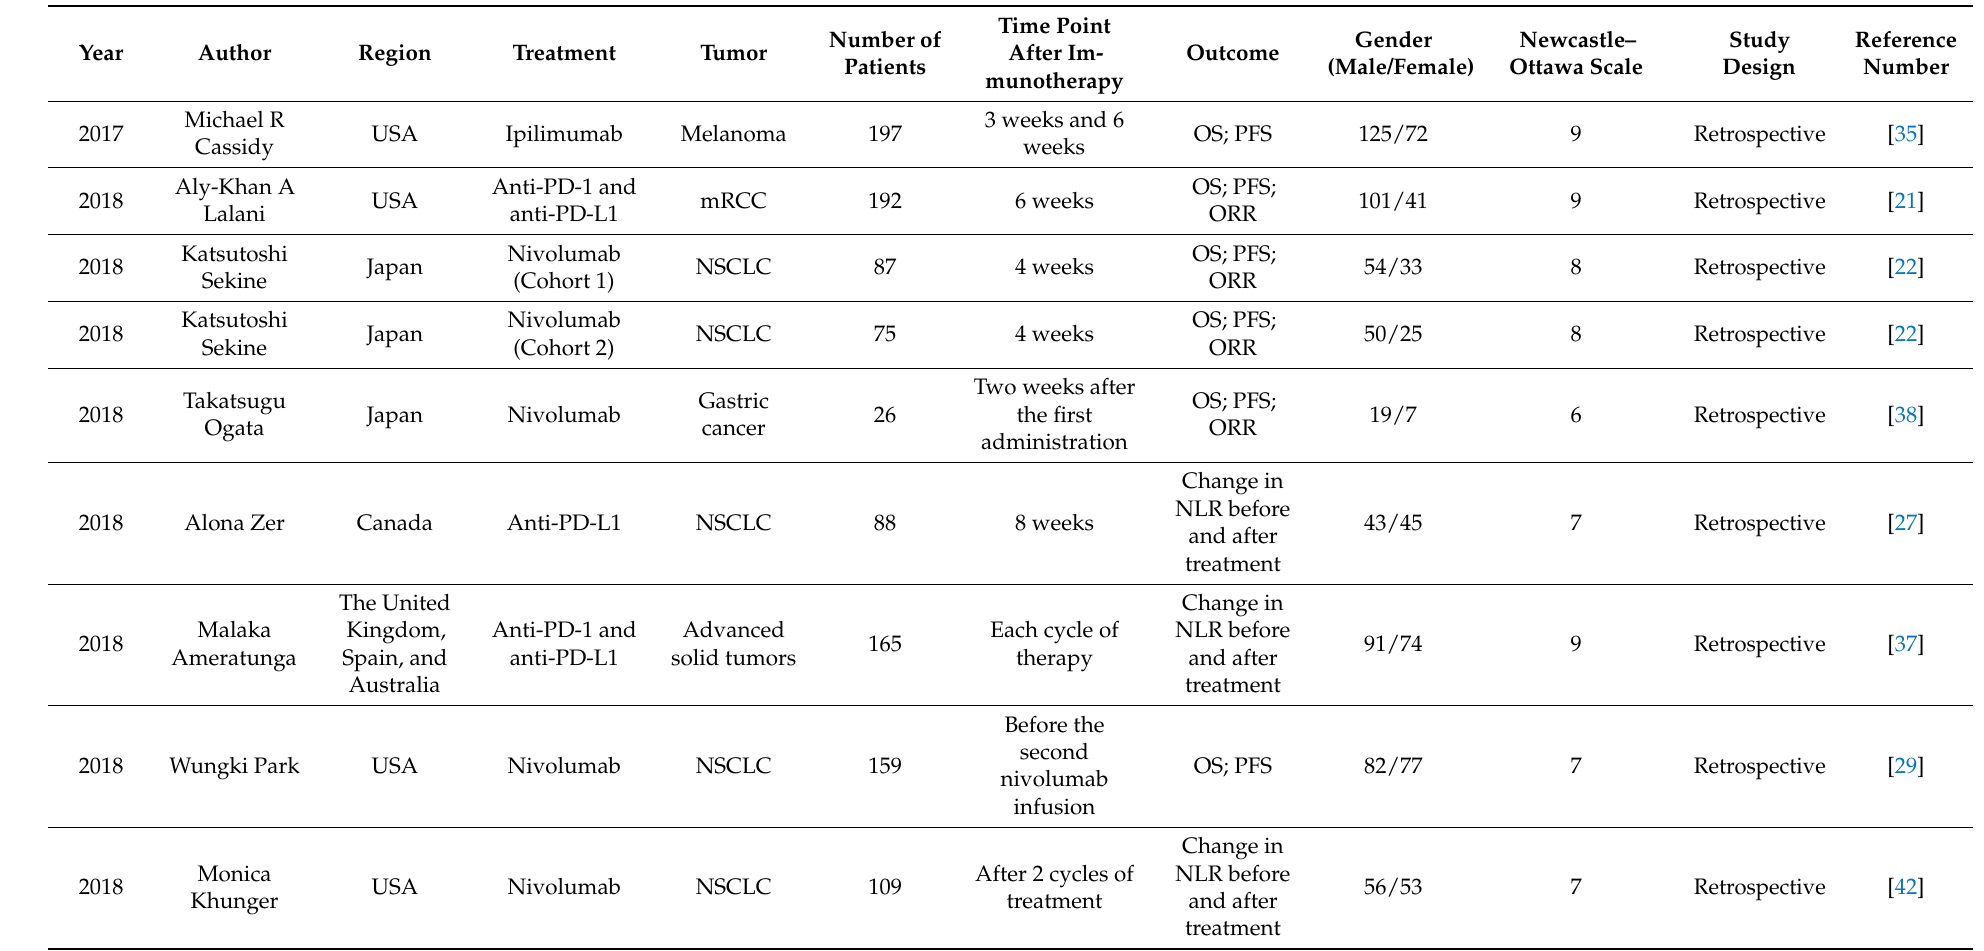
Table 1. Characteristics of included